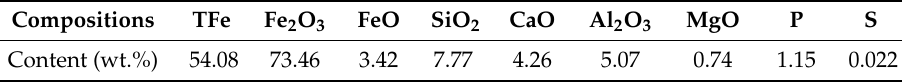
Table 1. Chemical composition of high-phosphorus iron